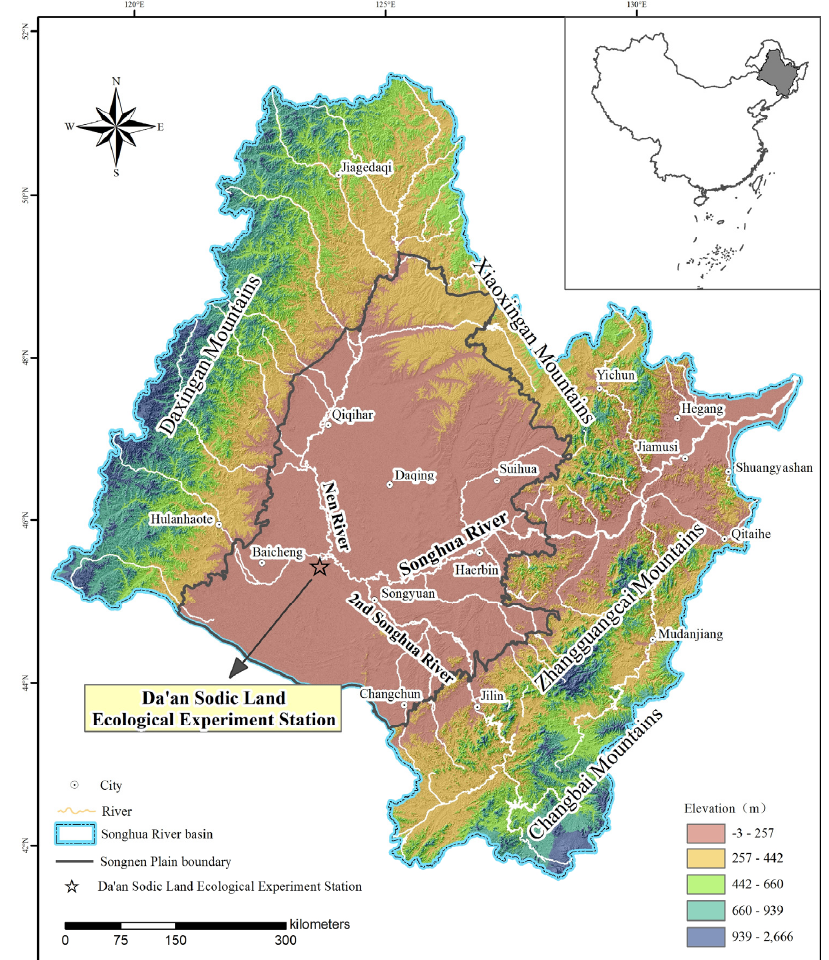
Figure 1. Location of Da’an Sodic Land Experimental Station.